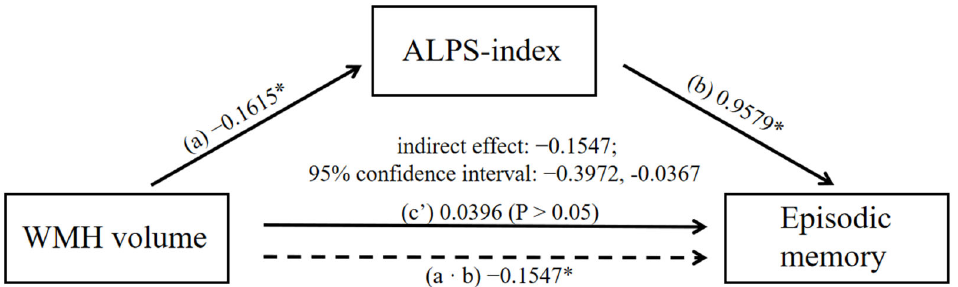
Figure 7. Mediating effect among WMH volume, ALPS ‐ index, and episodic memory score in the CSVD ‐ MCI group. Solid lines indicate direct effects (c’); dashed lines indicate indirect effects (a ∙ b). Associations are given as non ‐ standardized regression coefficients (non ‐ standardized ß). Gender, age, hypertension, and years of education were used as covariates. Abbreviations: WMH, white matter hyperintensities; ALPS ‐ index, the index of Diffusion Tensor Image Analysis along the Perivascular Space; CSVD, cerebral small vessel disease; MCI, mild cognitive impairment. *: p < 0.05.